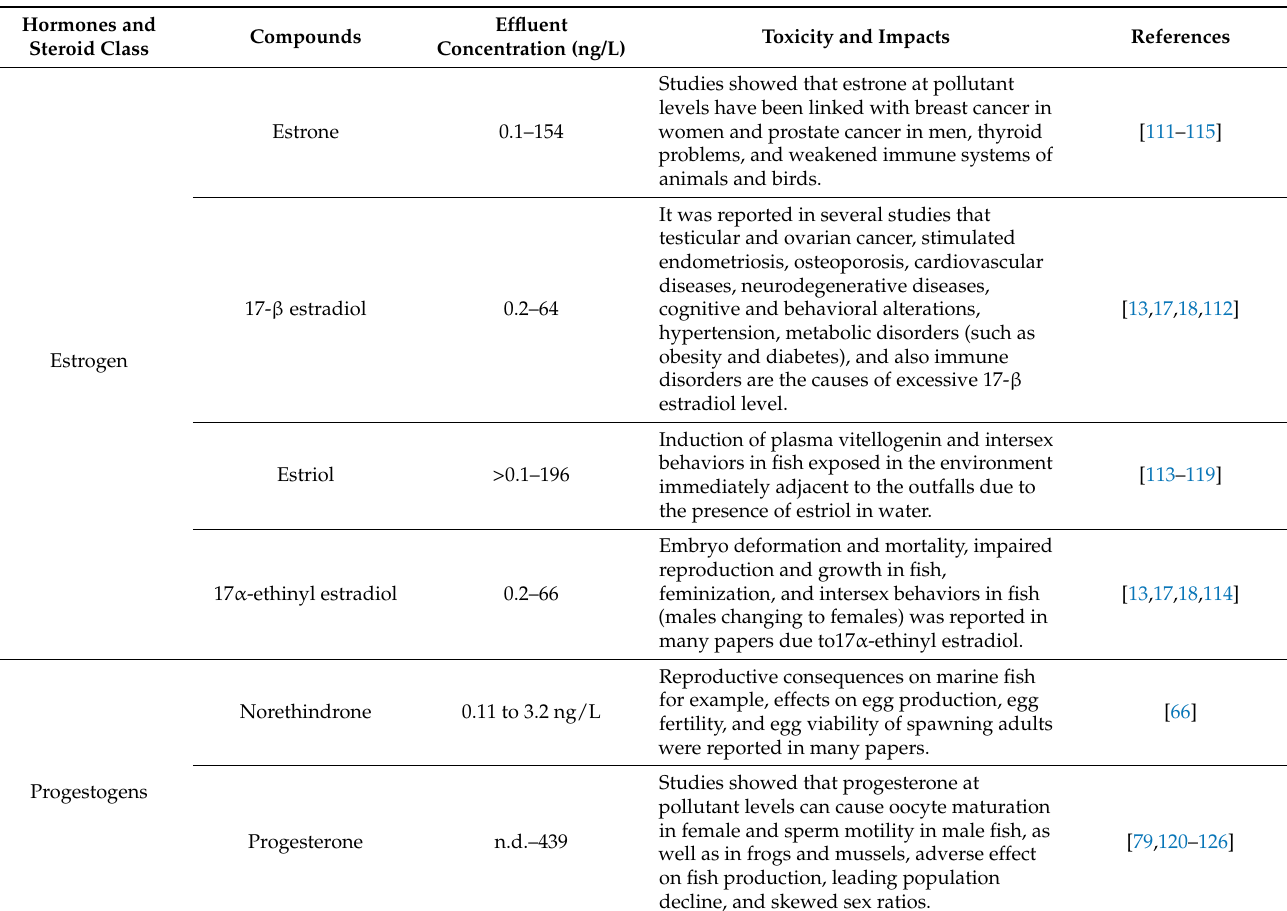
Table 3. Occurrence and health impact of